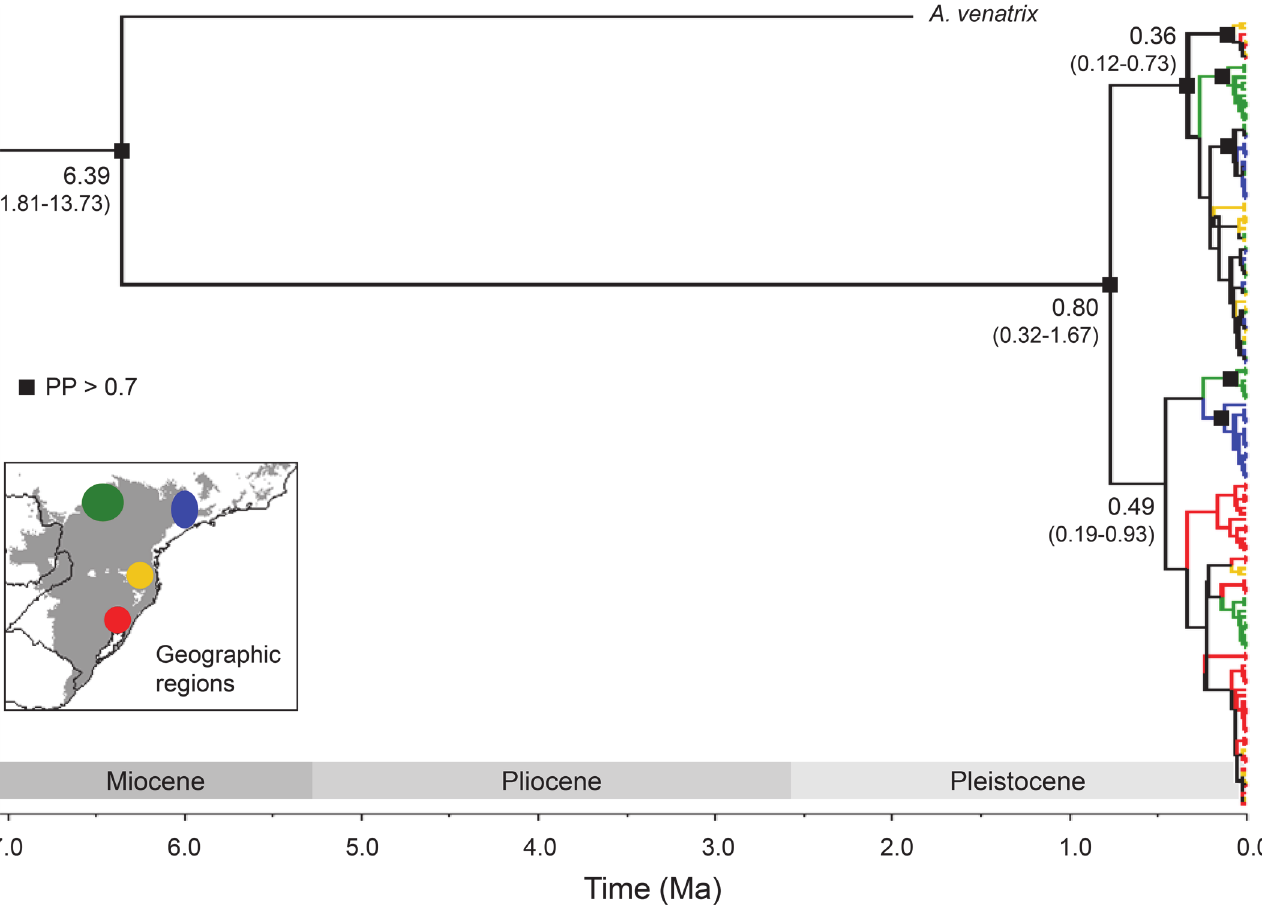
Fig 3. Bayesian phylogenetic inference for COI sequences. The divergence times of the main nodes are shown, with 95% HPD in parentheses. Black squares represent nodes with posterior probability > 0.7. Branch colors correspond to the geographical regions studied (map in